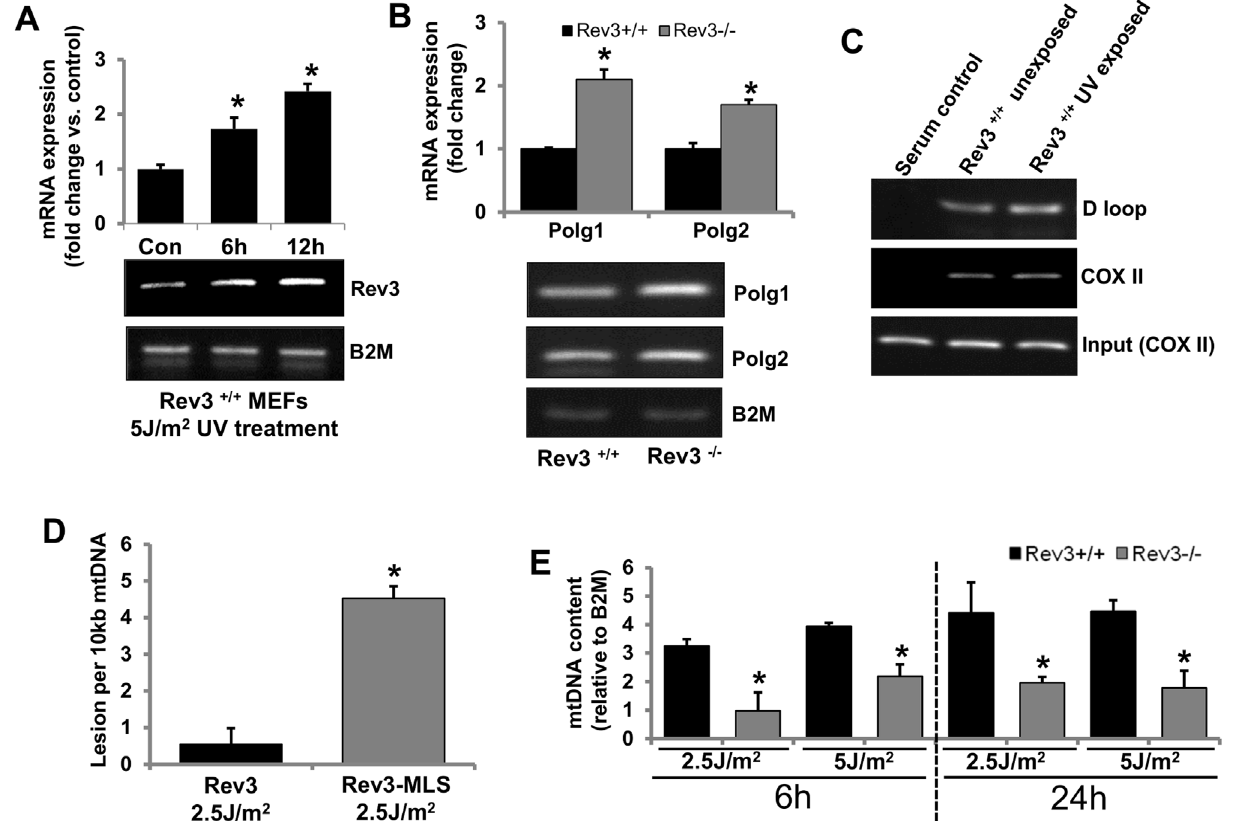
Fig 4. REV3 protects cells from mtDNA damage. ( A ) RT PCR results showing a time-dependent increase in Rev3 gene expression in Rev3 +/+ cells after UV exposure. The bar graph represents fold change in mRNA expression (mean ± s.d.) from at least three independent experiments. * P < 0.05 versus UV- unexposed control; Student's t-test. ( B ) RT PCR analysis showing increased expression of Polg1 and Polg2 in Rev3 -/- cells relative to Rev3 +/+ cells. The bar graph represents fold change in mRNA expression (mean ± s.d.) from at least three independent experiments. * P < 0.05 versus Rev3 +/+ ; Student's t-test. ( C ) Representative ChIP results showing binding of REV3 to the mtDNA (D loop and COX II region) in Rev3 +/+ cells. Experiment was carried out in triplicate. A further increase in REV3 binding to the D loop region is evident after UV exposure. ( D ) mtDNA damage analysis in UV-exposed (2.5 J/m 2 ) HEK293 cells expressing full-length Rev3 and HEK293 cells expressing Rev3 without the MLS (Rev3-MLS) after 6 h of exposure. Bars represent the mean ± s.d. * P < 0.05 versus full-length Rev3 expressing cells; Student's t-test. ( E ) mtDNA content of UV-exposed (2.5 and 5 J/m 2 ) Rev3 +/+ and Rev3 -/- cells after 6 and 24 h of exposure. Bars represent the mean ± s.d. * P < 0.05 versus respective UV-unexposed cells; Student's